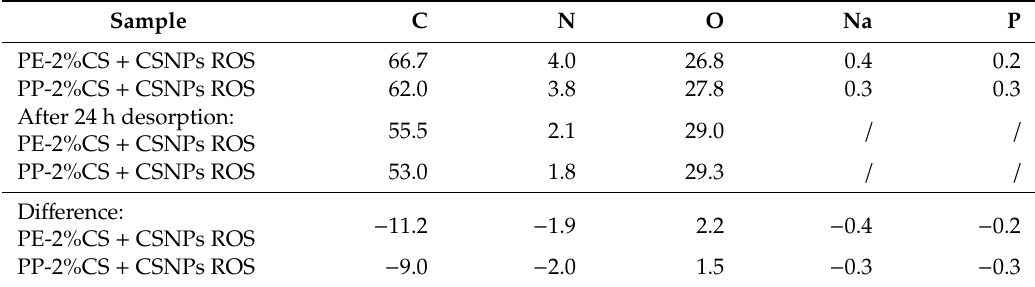
Table 7. Surface chemical composition of PE / PP-2%CS + CSNPs ROS-coated foils before and after desorption experiment in at.%.